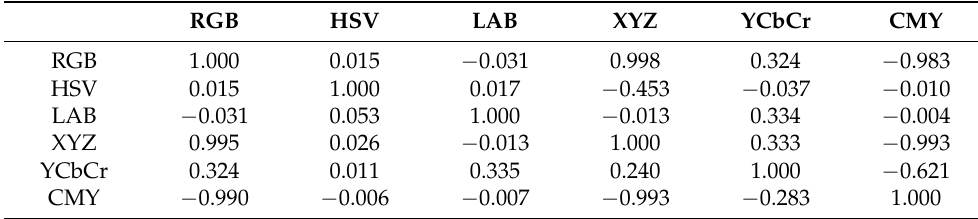
Table 2. Pearson correlation between color spaces.